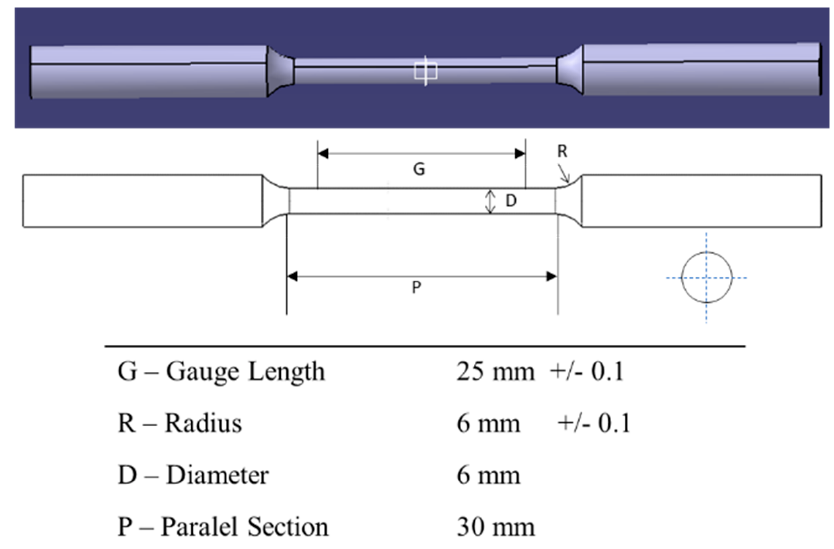
Figure 3. ASMT E8 Small Tensile Test Specimen Dimensions .